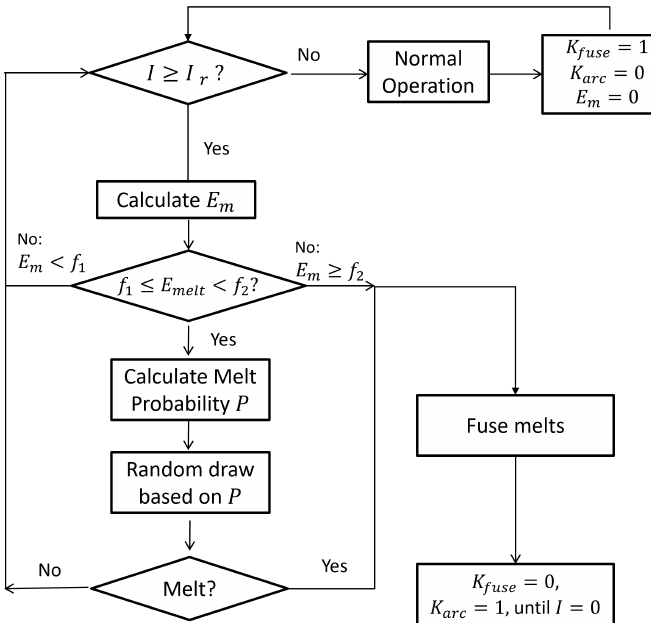
Figure 4. Operating flow chart of the probability-integrated fuse simulation model.